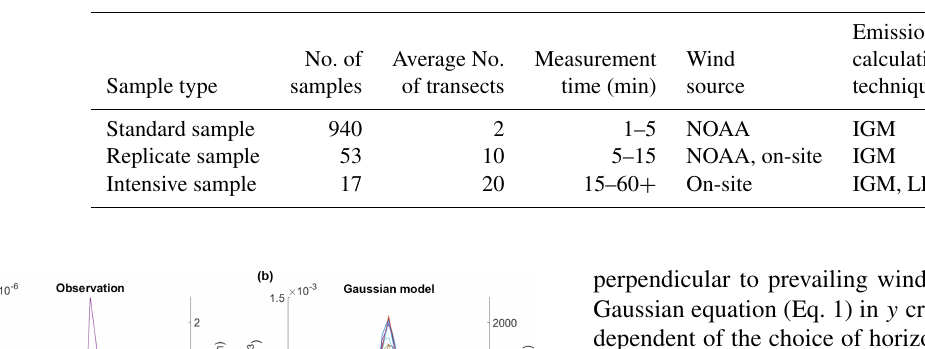
Table 2. Summary of acquired data and data level.